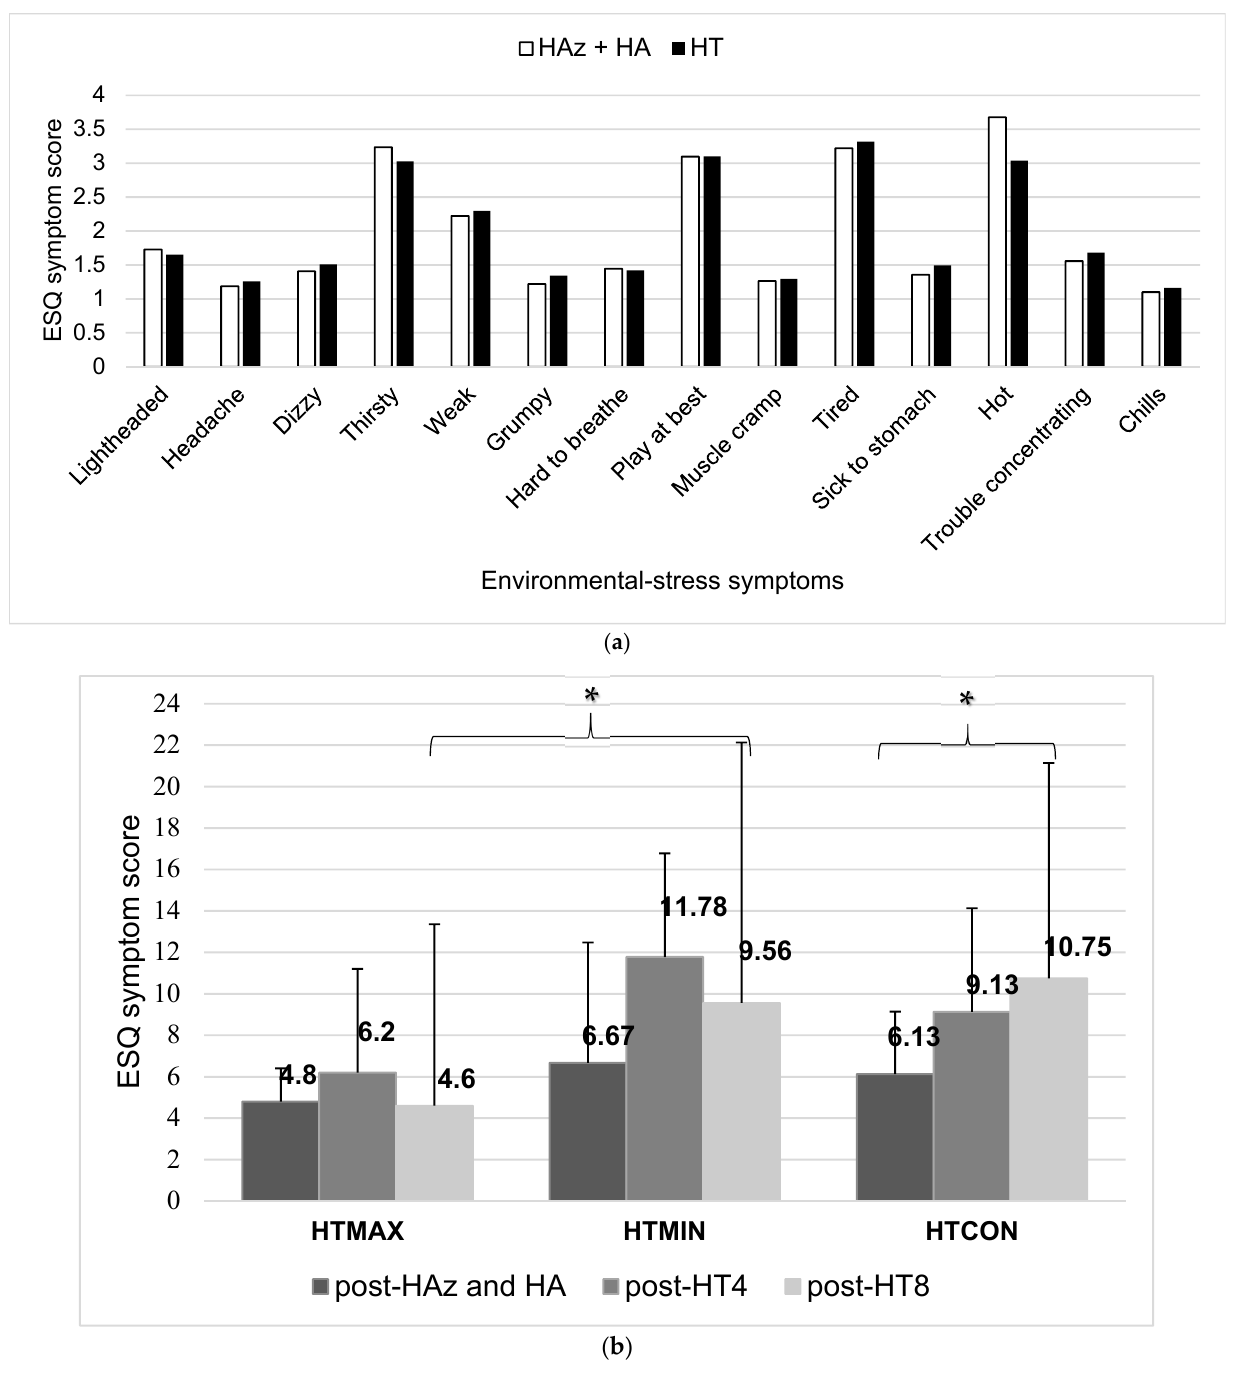
Figure 2. ( a ) Individual post-trial Environmental Symptoms Questionnaire (ESQ) scores following the combination of heat acclimatization (HAz) and heat acclimation (HA) and following heat training (HT). White bars represent average post-trial symptom scores during induction. Black bars represent average post-trial symptom scores during HT. ( b ) Visual representation of change from post-